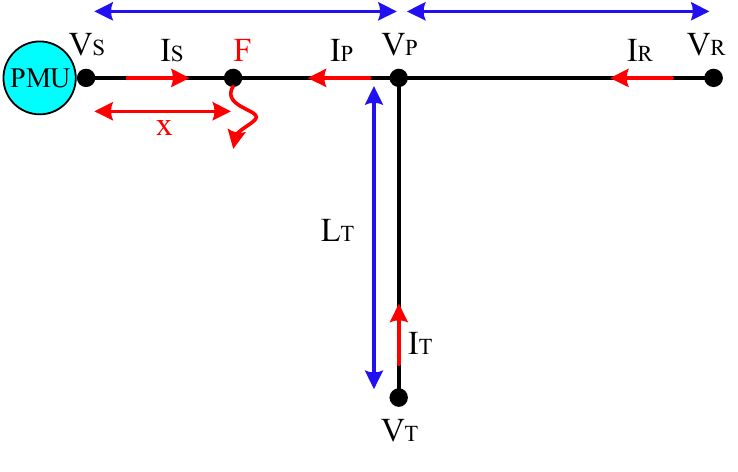
Figure 8. Sample network of 3 lines.